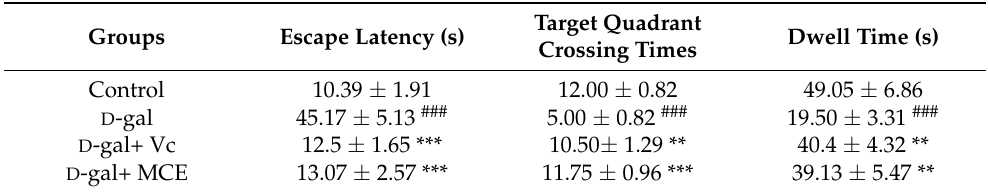
Table 2. Effects of MCE on escape latency, target quadrant crossing times and dwell time in MWM test.